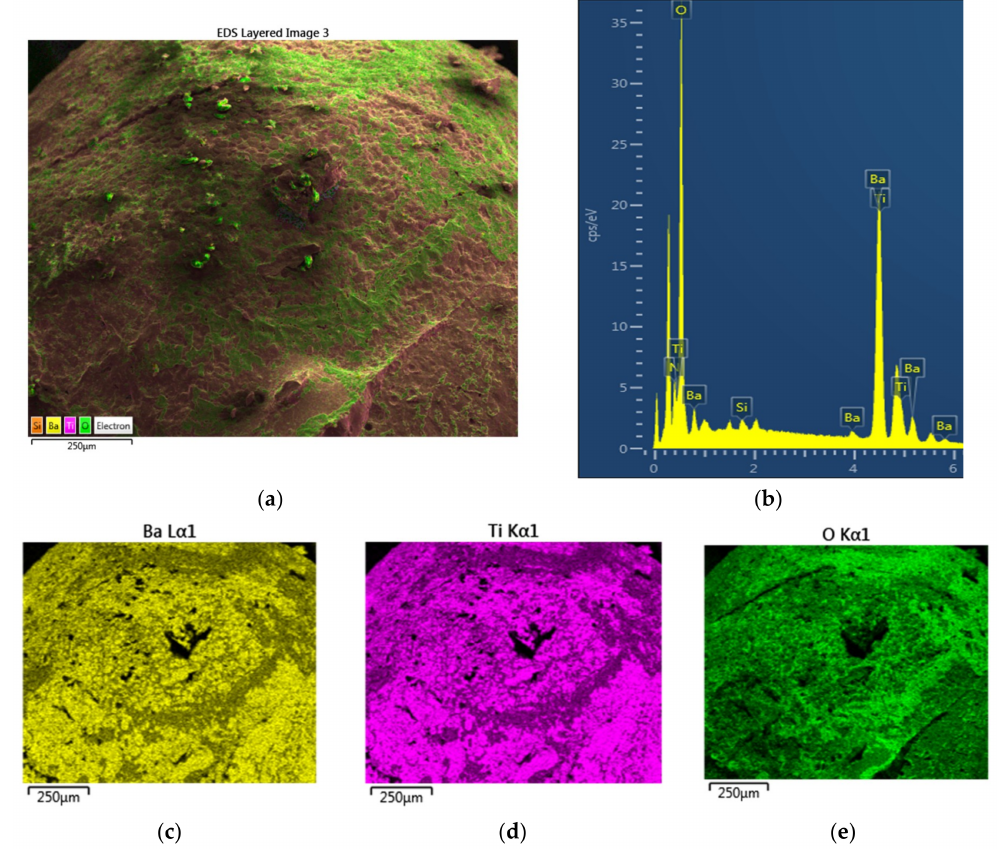
Figure 9. The e ff ect of 10 min microwave irradiation at 1800 W in air with plasma generation and the surface modification of BaTiO 3 particle (Particle-1 in Figure 8). ( a ) EDS layered image; ( b ) EDX-spectra of the area in ( a ) with composition: [O] = 0.681; [N] = 0.101; [Ba] = 0.123; [Ti] = 0.094. ( c ) Ba-mapping; ( d ) Ti-mapping and ( e )